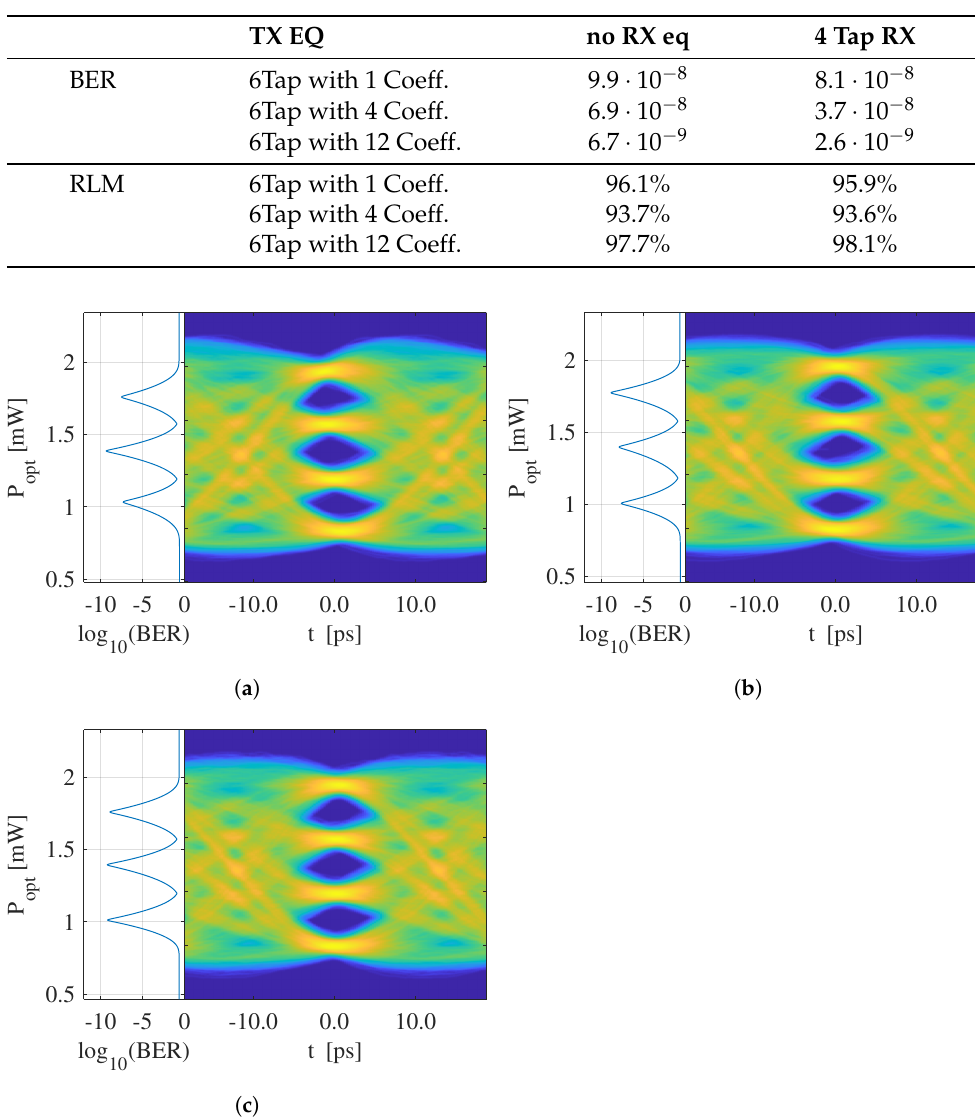
Table 2. Bit-Error Rates and RLM for different equalization settings at 40Gbaud.